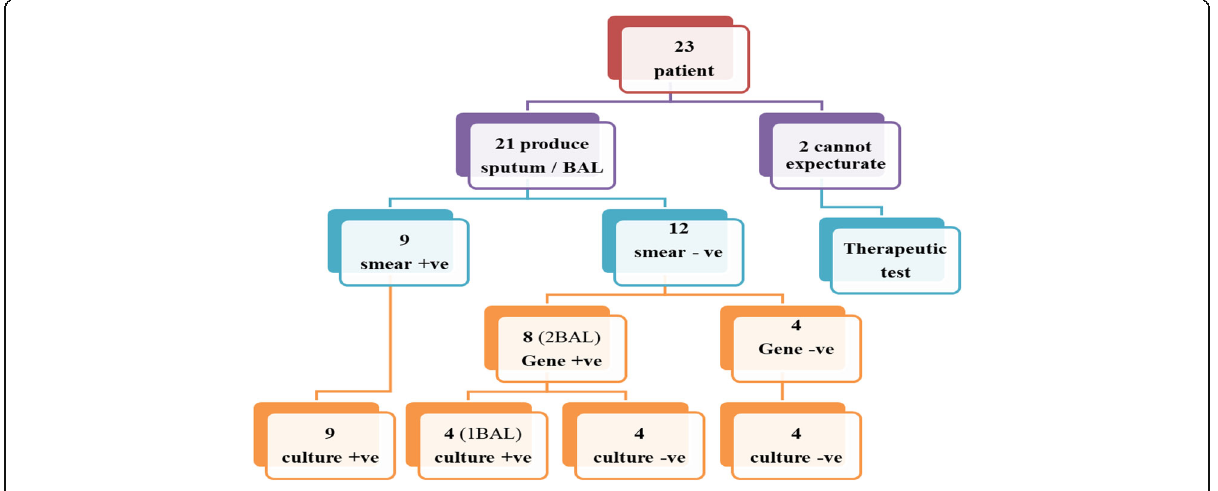
Fig. 1 Flowchart for TB diagnosis in TB group